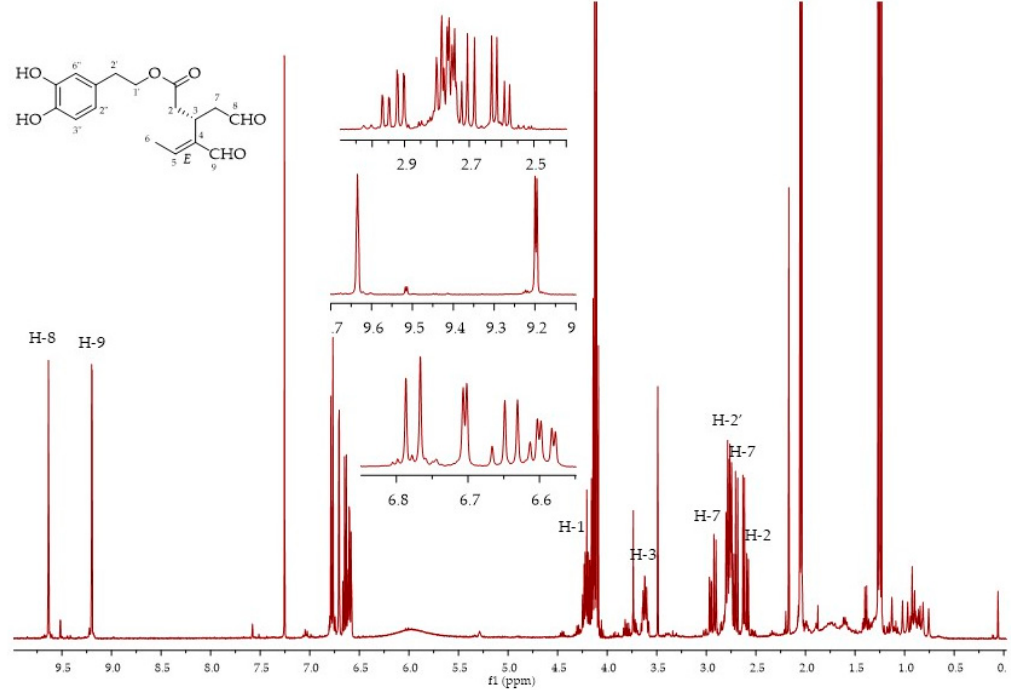
Figure 8. 1 HNMR spectra of fraction 7, oleacein (3 S ,4 E )- 10 . Figure 8. 1 H NMR spectra of fraction 7, oleacein (3 S ,4 E )- 10